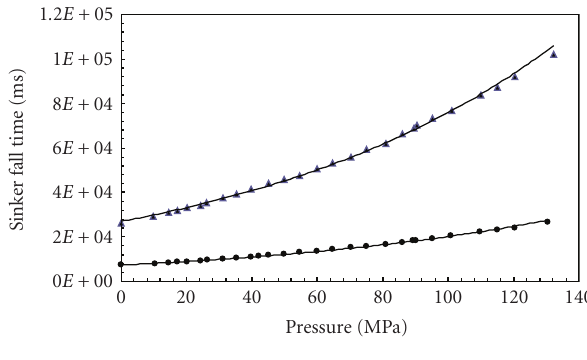
Figure 5: Sinker fall times. (cid:2) sinker 1; • sinker 2.